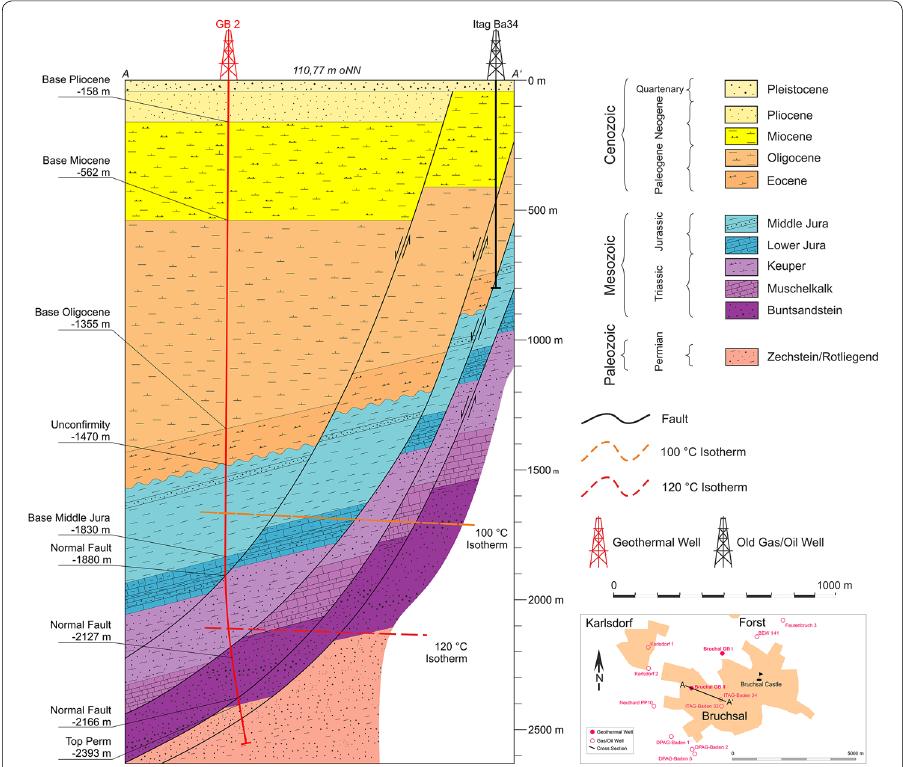
Fig. 2 Geological WNW–ESE cross section of the Bruchsal GB2 production well (Upper Rheine Valley, Baden-Württemberg, Germany). The figure represents a compilation of the work of Joachim et al. (1987)